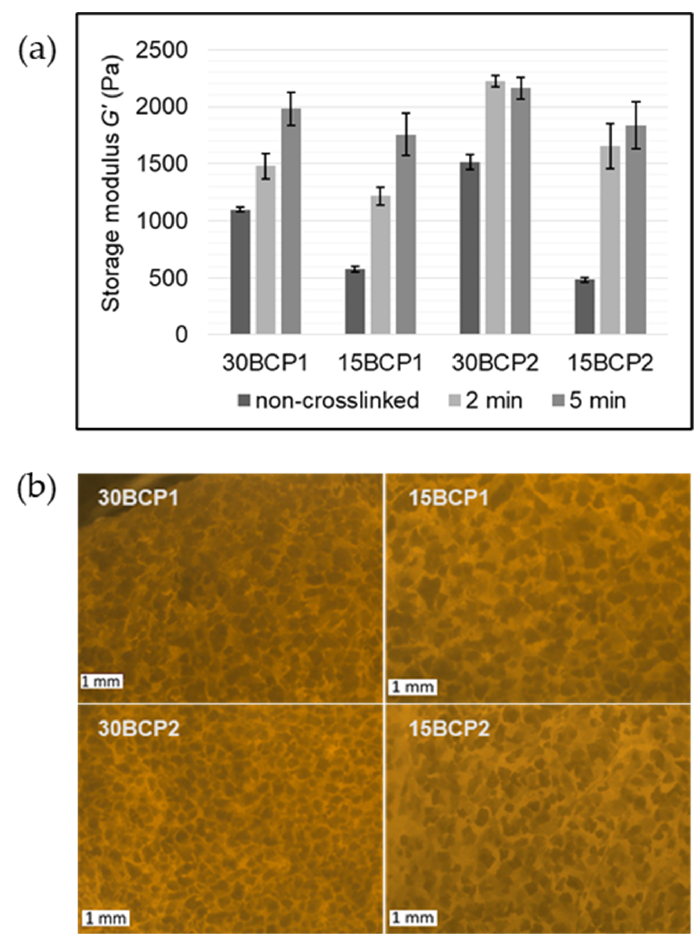
Figure 5. (a) Crosslinking effect in storage modulus (G ′ ) values at 1% strain. ( b ) Microscope images of ink samples cast in PLA 3D-printed molds. Scale bars are equal to 1 mm.